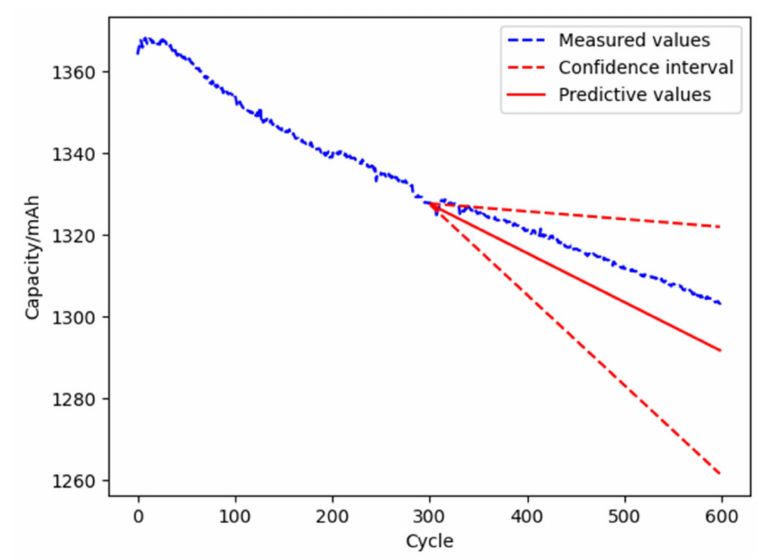
Figure 10. The prediction result of the randomness of battery degradation.